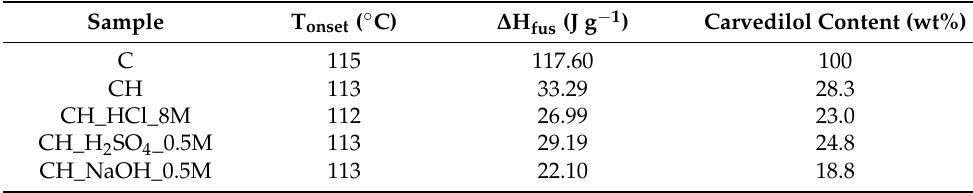
Table 4. DSC analysis data.